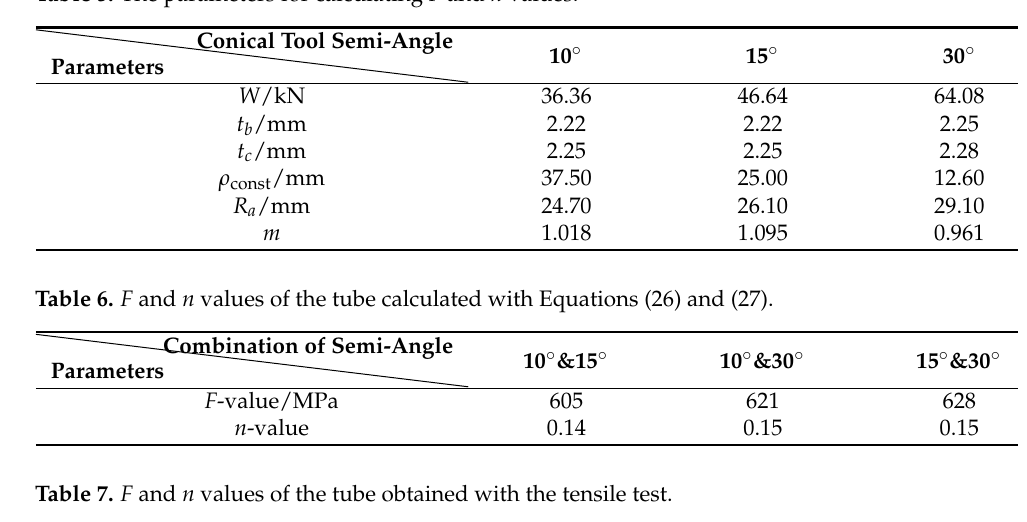
Table 5. The parameters for calculating F and n values.